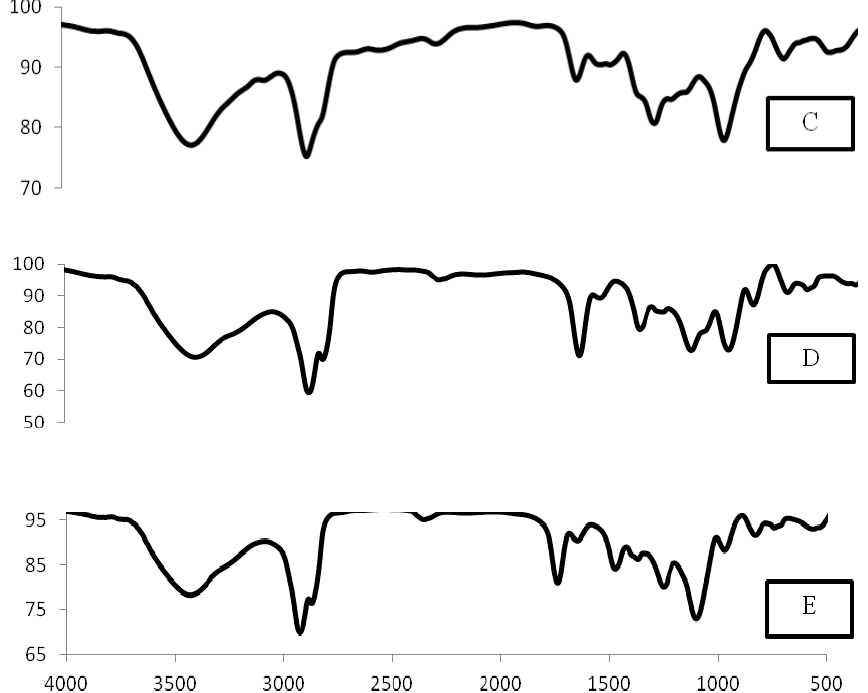
Figure 7. IR of ( A ) pure MIC, ( B ) physical mixture with Span 80, ( C ) physical mixture with Tween 80, ( D ) MIC Transfersomes with Span 80, and ( E ) MIC Transfersomes with Tween 80.